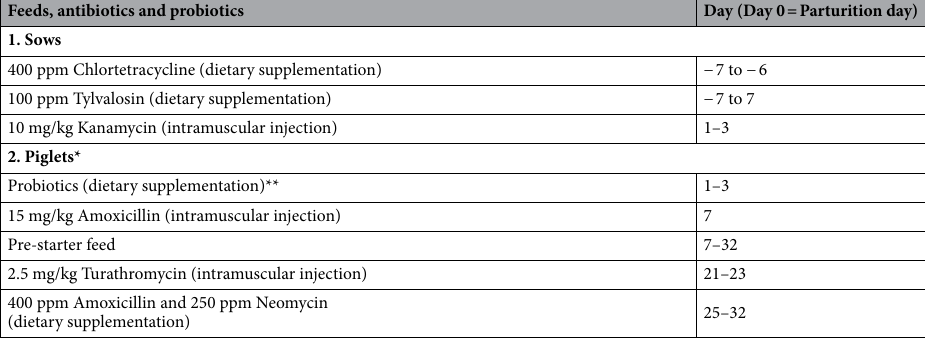
Table 5. Programs of feeds, antibiotics and probiotics for pregnant sows and piglets. *Ad libitum chlorine in water (1 tablet/ 1000 L water) was allowed. **Probiotics (Bactosac, K.M.P. Biotech, Chon Buri, Thailand): 10 9 colony-forming unit (CFU) each of B. subtilis , B. licheniformis , L. acidophilus , L. plantarum , Pediococcus pentosaceus and Sacchalomyces cerevisiae